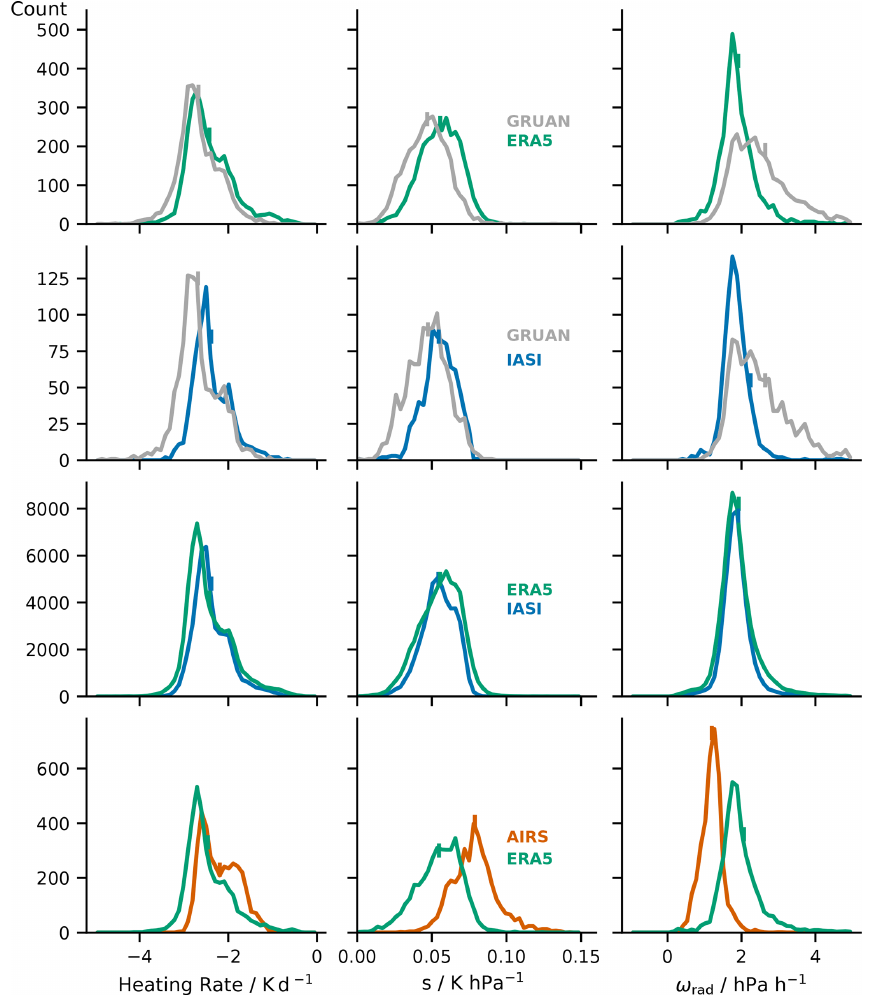
Figure 7. Distributions of moist-layer-associated longwave heating rate, static stability ( s ) and radiatively driven vertical velocity ω rad for the different collocation datasets. The averaging measure for heating rate is the median. s is calculated based on moist layer median temperature, potential temperature and potential temperature gradient. ω rad is calculated by division of moist-layer-associated heating rate and static stability. Vertical dashes indicate